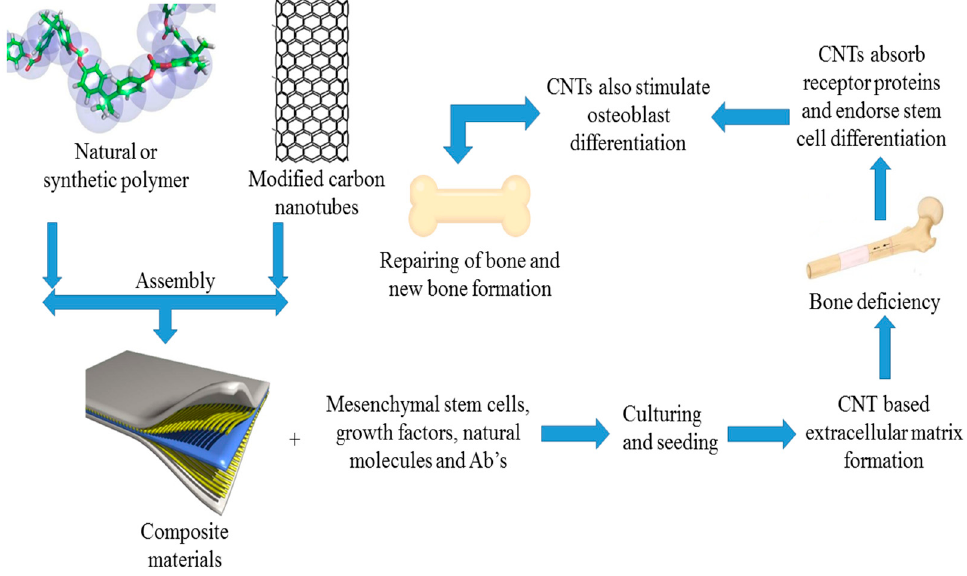
Figure 1. Schematic representing carbon nanotubes (CNTs) as a nanocomposite-based scaffold for use in bone regeneration and tissue engineering.